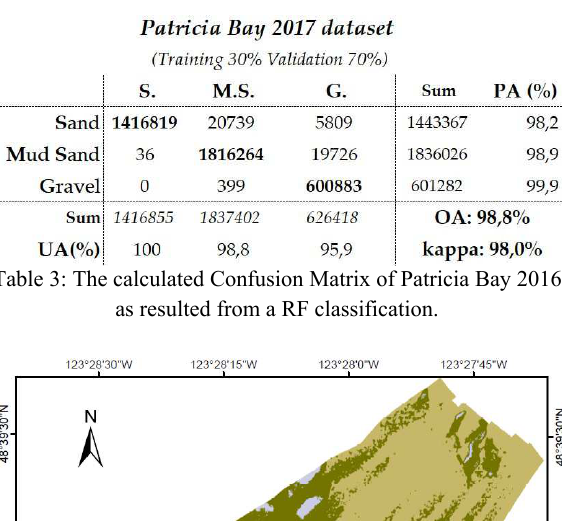
Figure 9: An indicative misclassification case indicated by red arrows at Patricia Bay 2016.